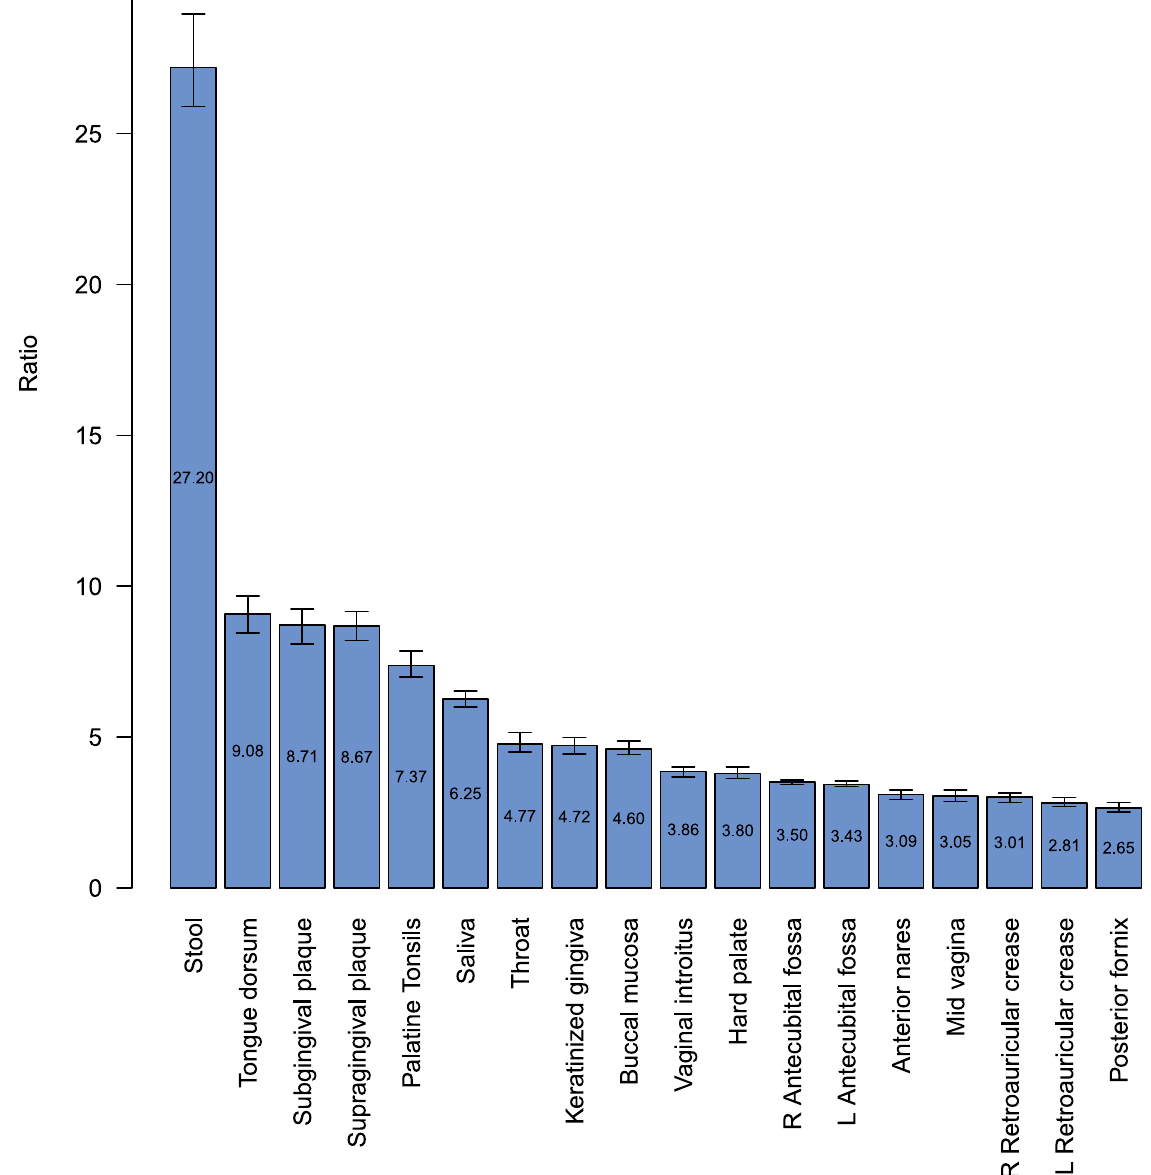
Figure 5. OTU-to-Genera ratios. The median ratio of OTUs to Genera was calculated and plotted from greatest to least for each body habitat. These medians and 95% confidence intervals were estimated with bootstrapping by resampling from the combined distribution of OTUs and Genera to a common read depth. The common read depth chosen was the body habitat with the least read coverage, left antecubital fossa. doi:10.1371/journal.pone.0032118.g005 taxonomic units with a measured abundance greater than or equal to 10%, 1%, 0.1%, and 0.01%, are assigned red, orange, yellow- green and green, respectively. To make the comparison of low abundance taxonomic units comparable between samples with four body regions based on the region with the shallowest abundance consistent among body regions.